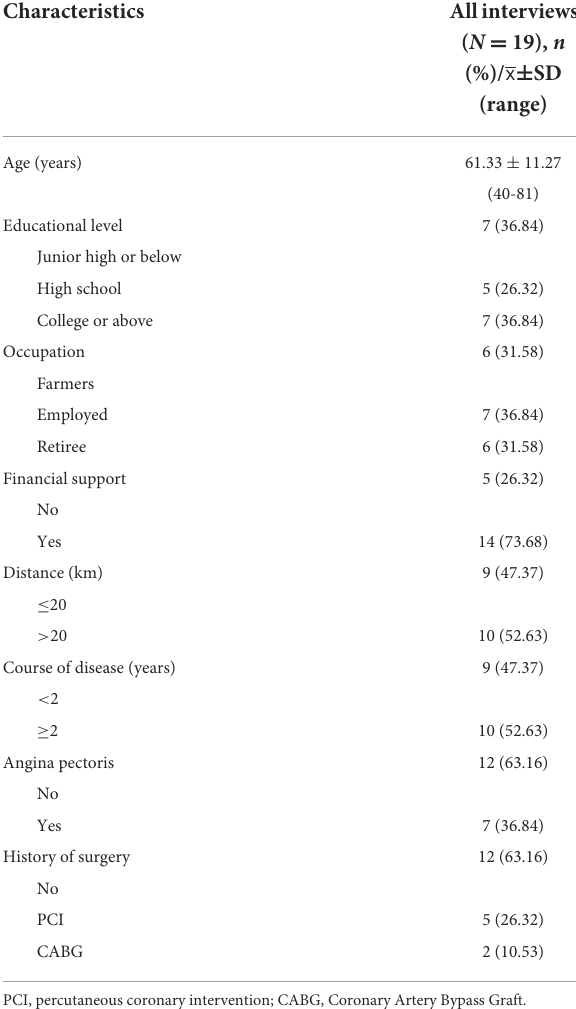
TABLE 3 General characteristics of participants in the qualitative study.